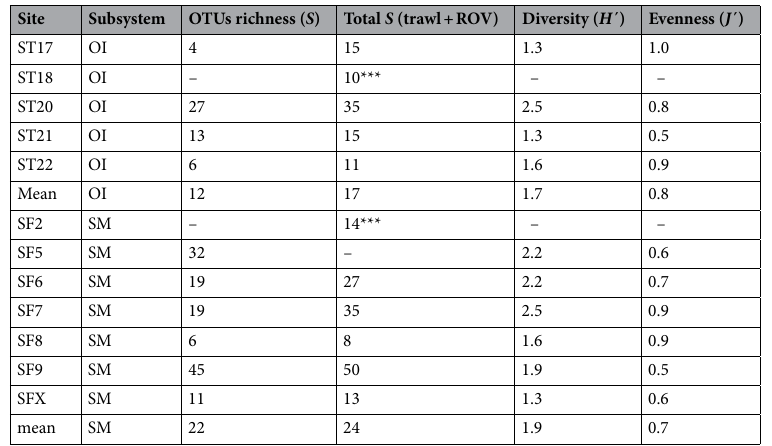
Table 2. OTU richness based on trawl data, total S (trawl + ROV) data and diversity and evenness indexes obtained from relative OTU abundances of only trawl data. Subsystem OI = oceanic islands and SM = seamounts. Only ROV